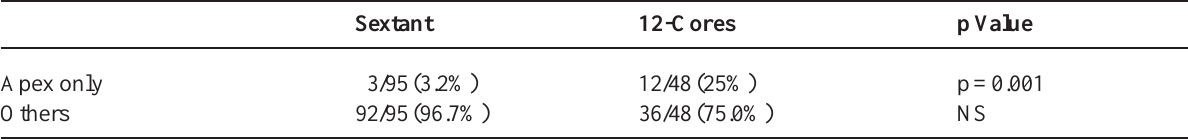
Table 4 – Diagnostic rates prostate cancer located in the anterior apex only and in other locations detected by sextant and 12-core